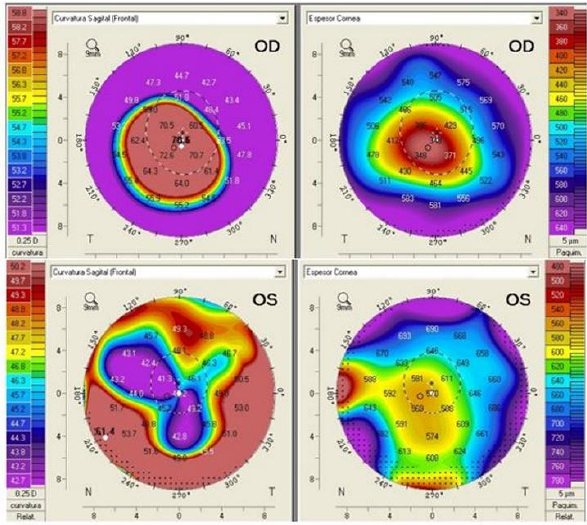
Figure 2 : Corneal topography on first follow-up, year 4 after the diagnosis, showing progression of keratoconus on OD, with maximum keratometry value of 78.5D (a) and minimal corneal thickness of 335 μm (b). OS shows a maximum keratometry value of 61.5D (c) and minimal corneal thickness of 564 μm